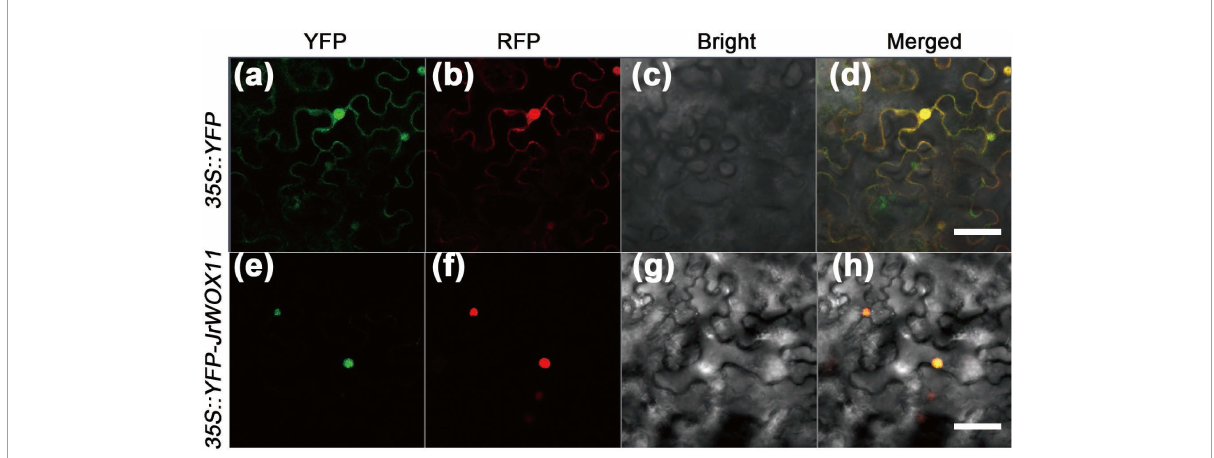
FIGURE3 Subcellular localization of JrWO11 protein. 35S::YFP and 35S::YFP-JrWO11 fusion proteins were expressed transiently into Nicotiana benthamiana leaf epidermal cells 48 ∼ 56 h after vacuum injection. The YFP channel (a,e) , the RFP channel (b,f) , the bright field (c,g) , and the merged images (d,h) . Scale bar: 50 µ m.